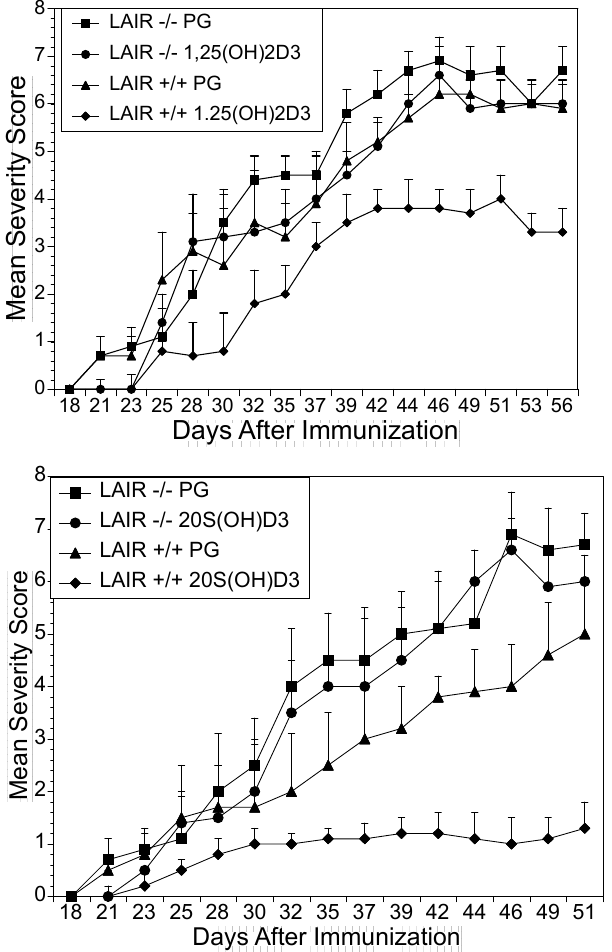
Figure 5. Treatment of LAIR-1 − / − mice with 1,25(OH) 2 D3 or 20S(OH)D3. (Upper Pane) Treatment with 1,25(OH) 2 D3. 20 DR1 LAIR-1 +/+ and 20 DR1 LAIR-1 − / − mice, were immunized with CII/CFA to induce an arthritic response and were observed for the development of arthritis. Each LAIR-1 +/+ and LAIR-1 − / − mouse was treated with an oral dose of either vehicle control (propylene glycol, 0.1 mL/dose) or 1,25(OH) 2 D3 (23 µg/dose). The mice were scored visually for severity of disease and the mean severity of arthritis scores for each group were calculated. (Lower Panel) Treatment with 20S(OH)D3 . 10 DR1 LAIR-1 +/+ and 10 DR1 LAIR-1 − / − mice, were immunized with CII/CFA to induce arthritis. Beginning on day 13 and continuing to day 48, each LAIR-1 +/+ and LAIR-1 − / − mouse was